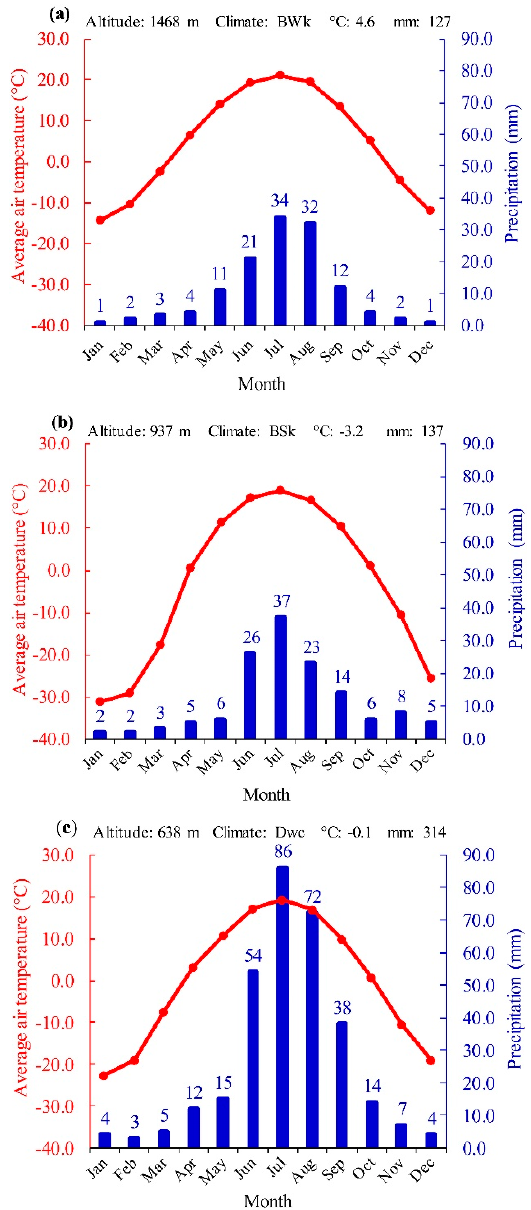
Figure 2. Climate graphs of the three most prevalent climatic zones in Mongolia [52]. ( a ) Dalanzadgad with cold desert climate (BWk), ( b ) Ulaangom with cold semi-arid climate (BSk), and ( c ) Sukhbaatar with cool continental climate / subarctic climate (Dwc). Information about altitude, average annual air temperature, and total precipitation is provided in each sub-plot. The data reflect long-term averages ( > 30 years).